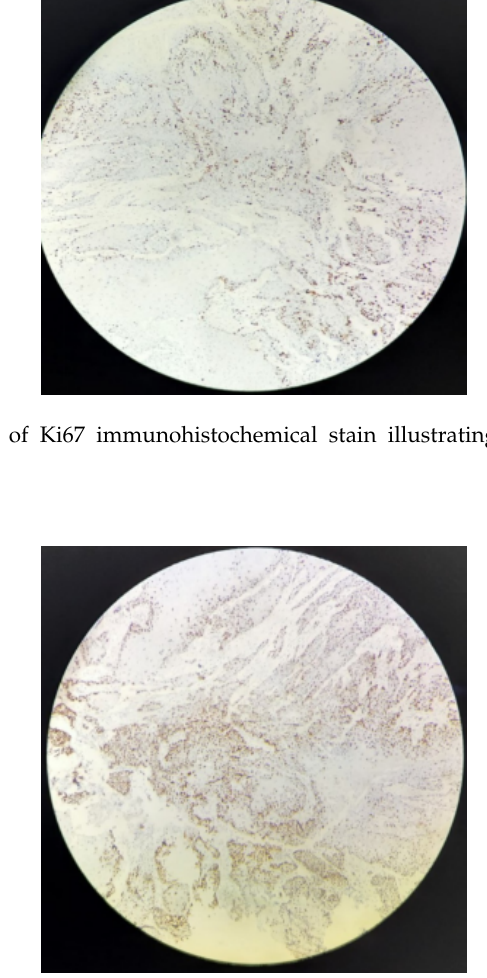
Figure 6. Photomicrograph of Ki67 immunohistochemical stain illustrating grade 6 positivity with 80% positivity (10x